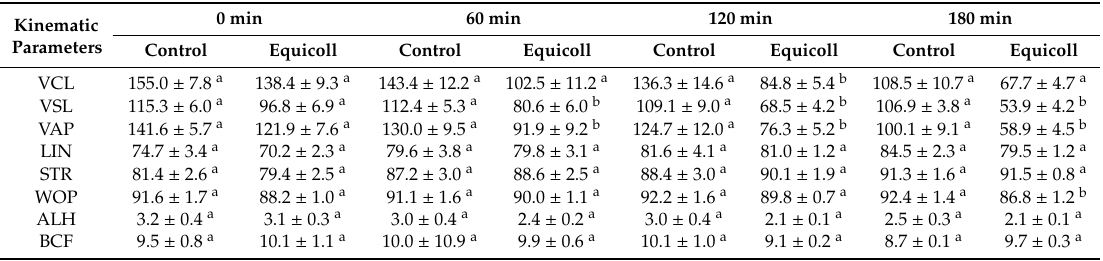
Di ff erent superscript letters (a, b) indicate significant di ff erences ( p ≤ 0.05) between treatments at 0, 60, 120, and 180 min. Data are shown as mean ± SEM for 10 separate experiments. VCL: sperm curvilinear velocity ( µ m / s); VSL: sperm linear velocity ( µ m / s); VAP: mean velocity ( µ m / s); LIN: linear coe ffi cient (%); STR: straightness coe ffi cient (%); WOB: wobble coe ffi cient (%); ALH: mean lateral head displacement ( µ m); BCF: frequency of head displacement (Hz). SLC: single layer